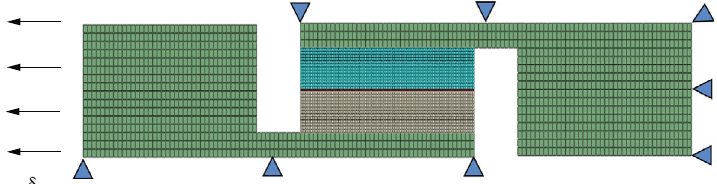
Figure 16: Finite element model and corresponding boundary conditions of the SLJ